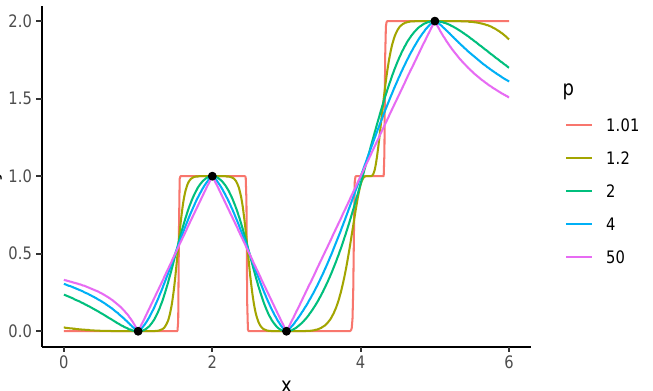
Figure 2. Interpolation of the points ( 1,0 ) , ( 2,1 ) , ( 3,0 ) , and ( 5,2 ) using the formula of 2 for different values of p . The measure considered is the counting normalized measure µ =